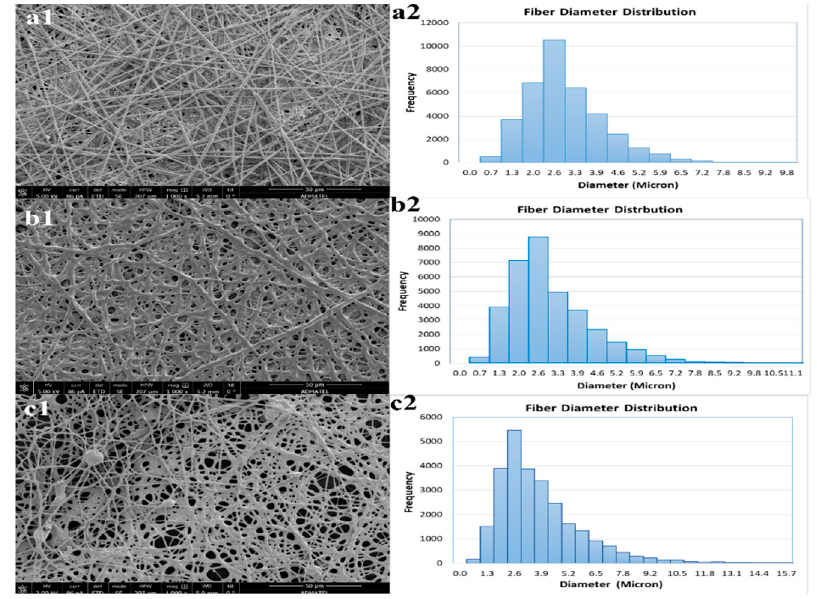
Figure 5. Fiber diameter distribution based on SEM micrographs of: ( a1 , a2 ) ES-SDIB / PBz-0; ( b1 , b2 ) ES-SDIB / PBz-5; and ( c1 , c2 ) ES-SDIB / PBz-10 (Magnification: 1000 × and scale bar: 50 µ m).